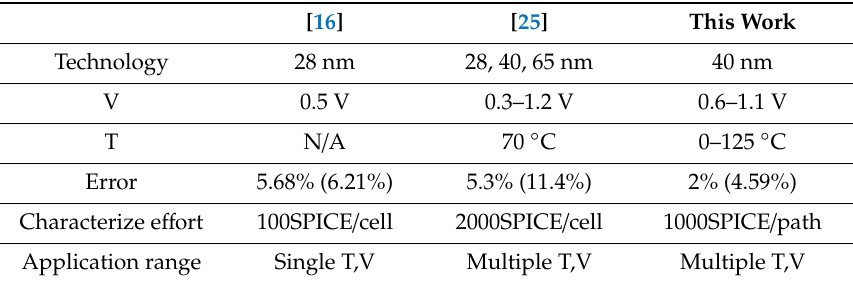
Table 4. Comparison with previous